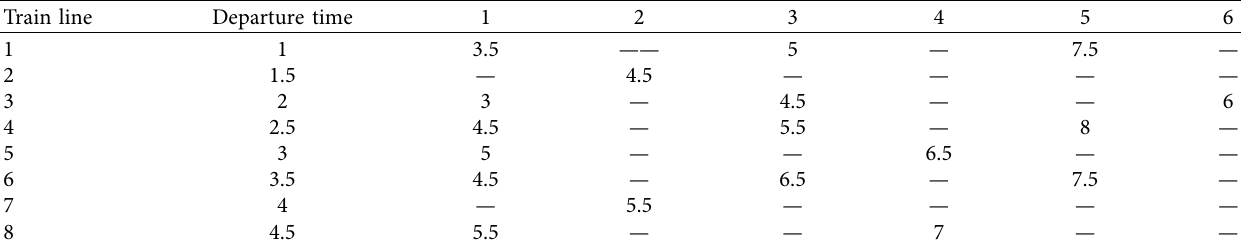
Figure 6: Illustration of a sample network. Table 1: Timetable of the sample